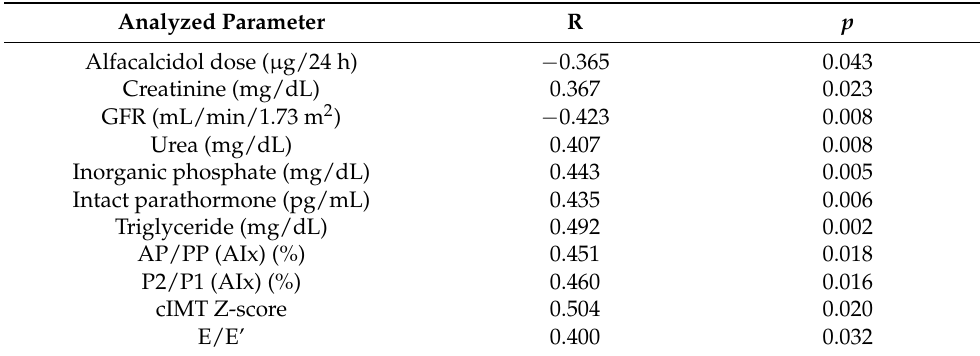
GFR—glomerular filtration rate, AP—augmentation pressure, PP—pulse pressure, Aix—augmentation index, P—peak pressure, cIMT—carotid intima-media thickness, E—peak wave velocity in early diastole, E’—mean value of peak medial and lateral mitral annular velocity during early filling by tissue